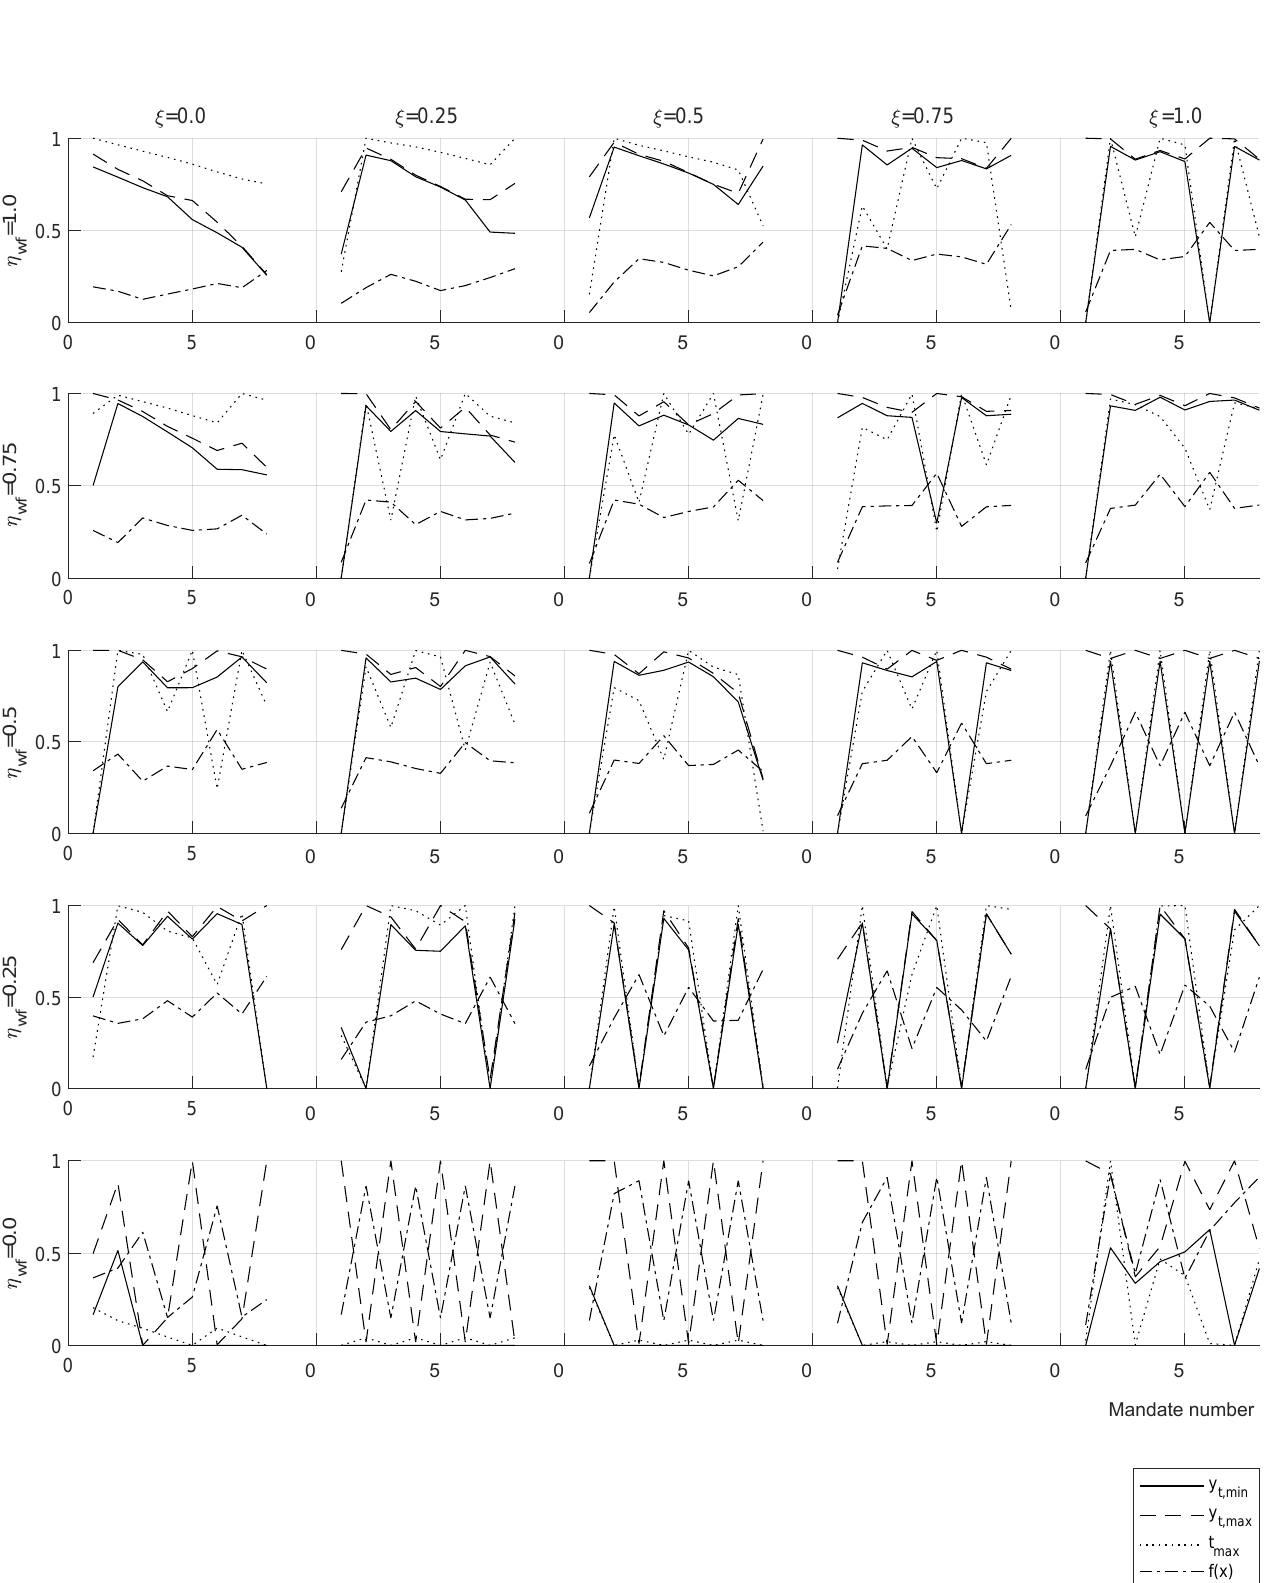
Figure A8. Tax policy evolution under yardstick vote during eight mandates for a series of welfare efficiency values η wf and tax disincentive ξ . Per citizen criterion. Mandate length: 8 years. Voters improvement demand